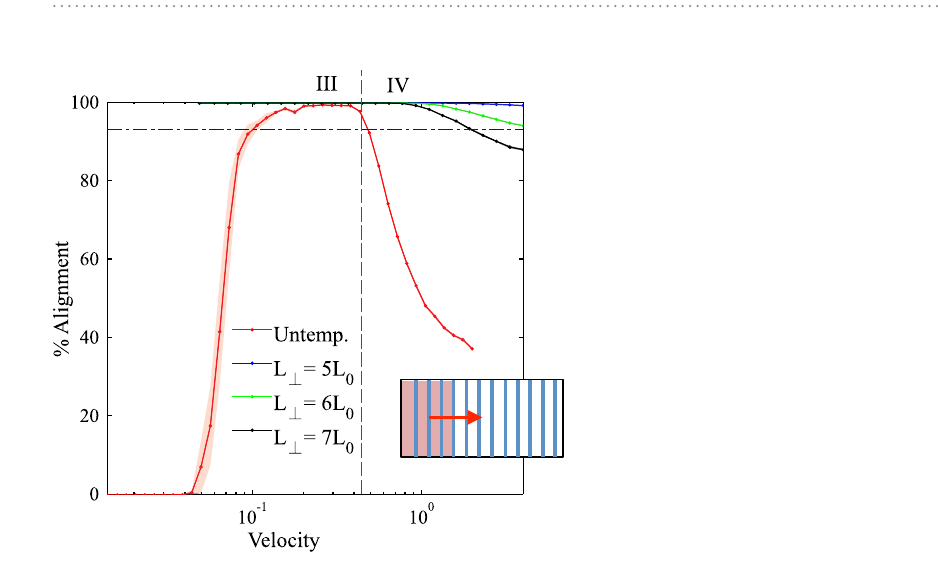
Figure 13. The percent alignment to within ± 30 degrees of the direction perpendicular to the zone velocity for samples with perpendicular (vertical) template stripes. The zone width is w zone = 80 ˜ l . Perpendicular template stripes provide the greatest shift in zone velocities for defect-free lamellae morphologies. For comparison, the horizontal line shows average alignment of isothermally annealed samples with templating at L || = 5 L 0 with annealing times equivalent to lowest velocity annealing times. Inset: template alignment (blue) is perpendicular to zone velocity